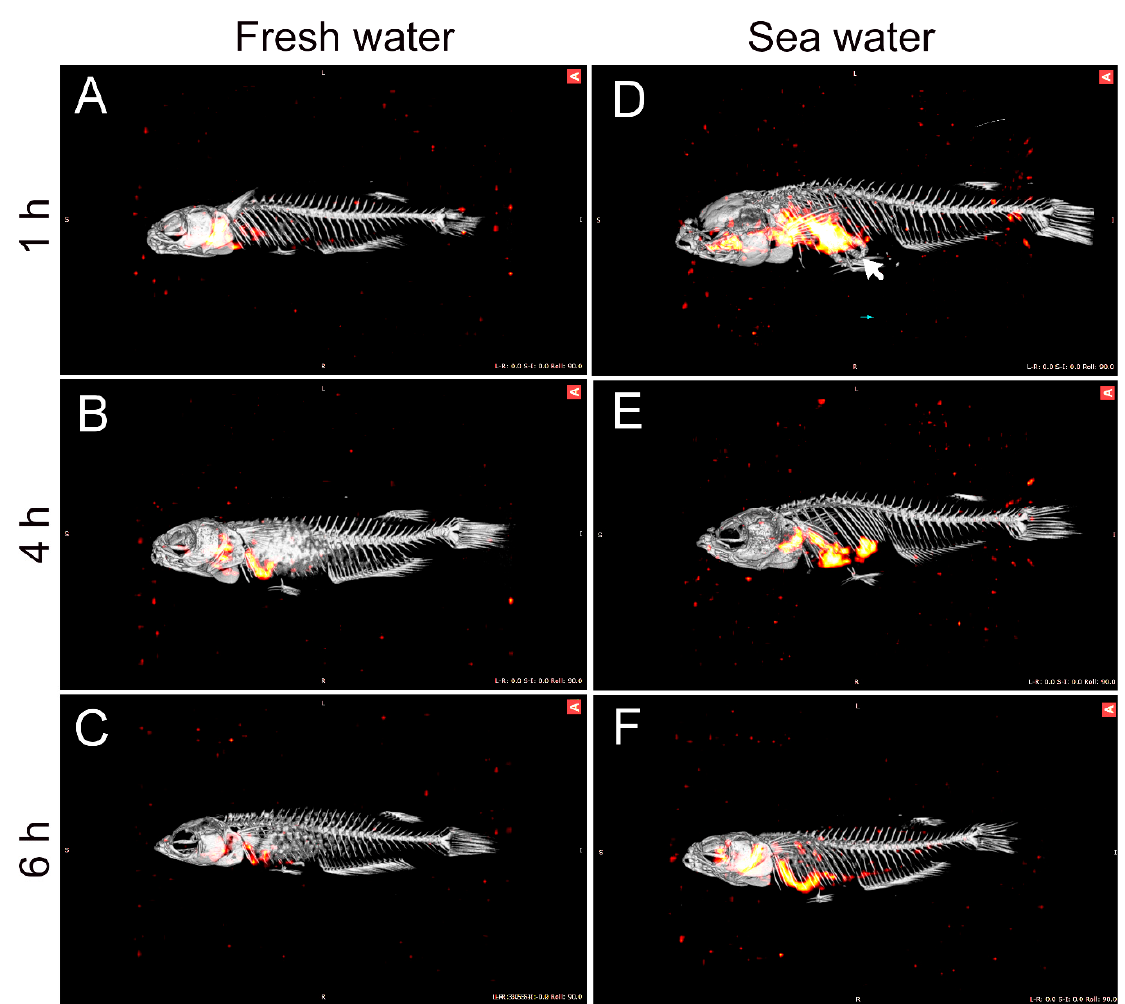
Figure 3. Visualization of the movement of imbibed water along the gastrointestinal tract of medaka acclimated to FW ( A – C ) or SW ( D – F ). Images are merged from single photon emission computed tomography (SPECT) (red intensity layer) and computed tomography (CT) (gray) scans of fish which had been incubated in 99-Tc-DTPA traced FW or SW for 1 h followed by transfer to non-radioactive FW or SW for 1 h ( A , D ), 4 h ( B , E ), or 6 h ( C , F ). The SPECT layer visualizes the localization (and intensity) of imbibed isotope-labeled water and the CT layer visualizes mineralized structures (skeleton and mineral precipitates in the SW intestines, white arrow in D ). Note that 99-Tc has a short half-life (6 h), which influences the apparent intensities of the imbibed isotope. The fish was approximately 3 cm in